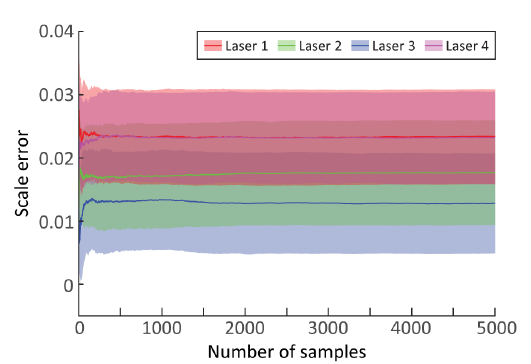
Figure 19. Evolution of scale error estimate with increasing number of MC iterations.